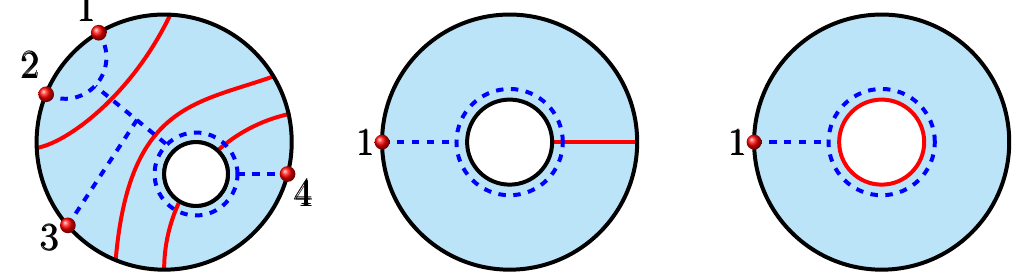
Figure 11 . Examples of Feynman diagrams dual to choices of arcs. The middle and right (cid:12)gures show how tadpoles are created, we call these \IR" and \UV" tadpole